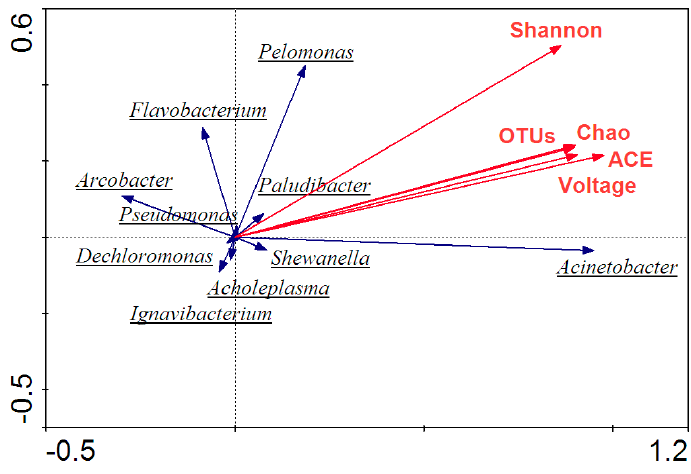
Figure 10. Redundancy analysis at the genus level.